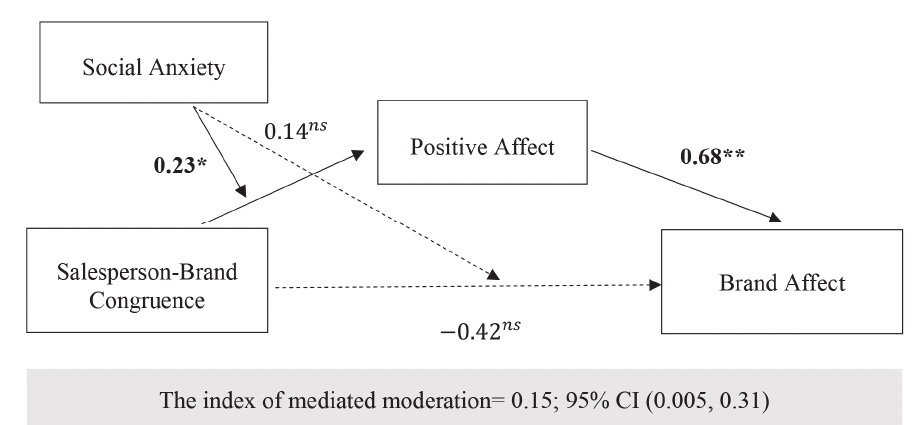
<Figure 4> Mediated Moderation Analysis (Study 2,